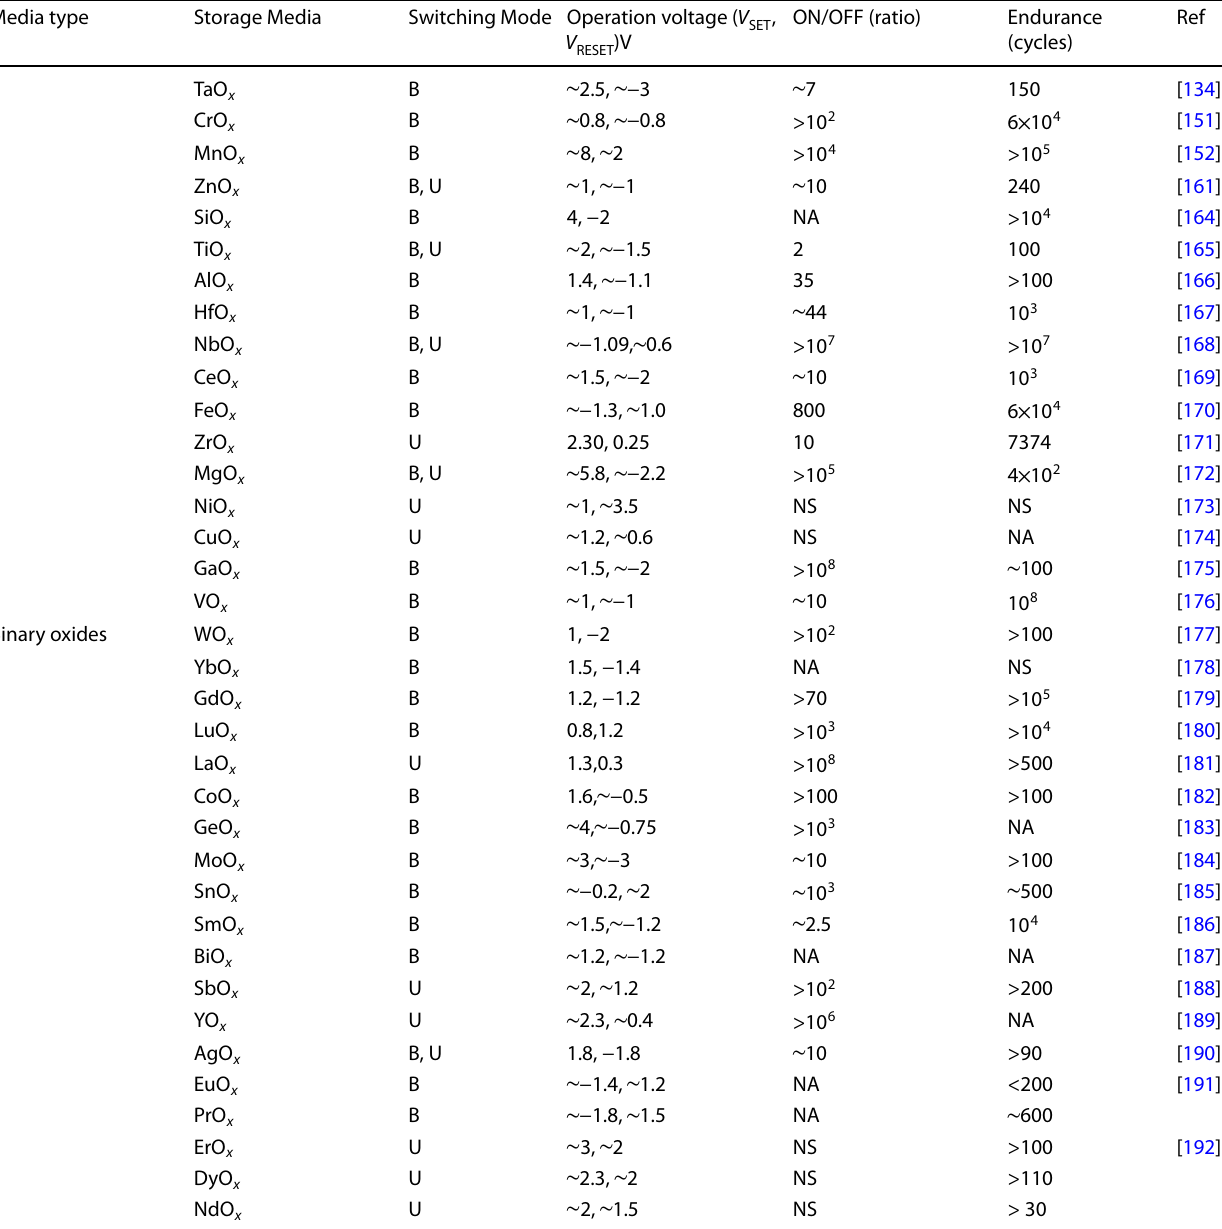
Table 1 Summary of the RRAM Binary storage media and their